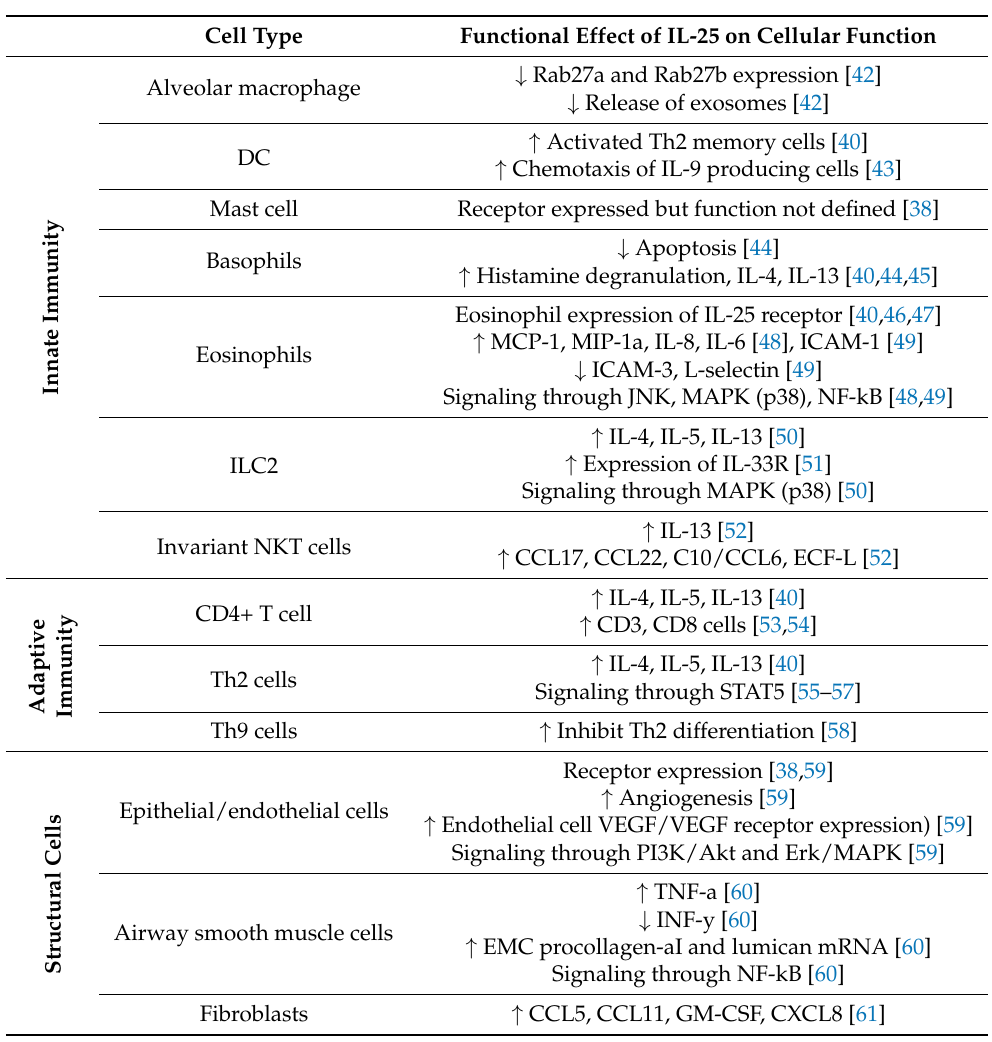
Table 1. IL-25 and pathogenic effects in asthmatic